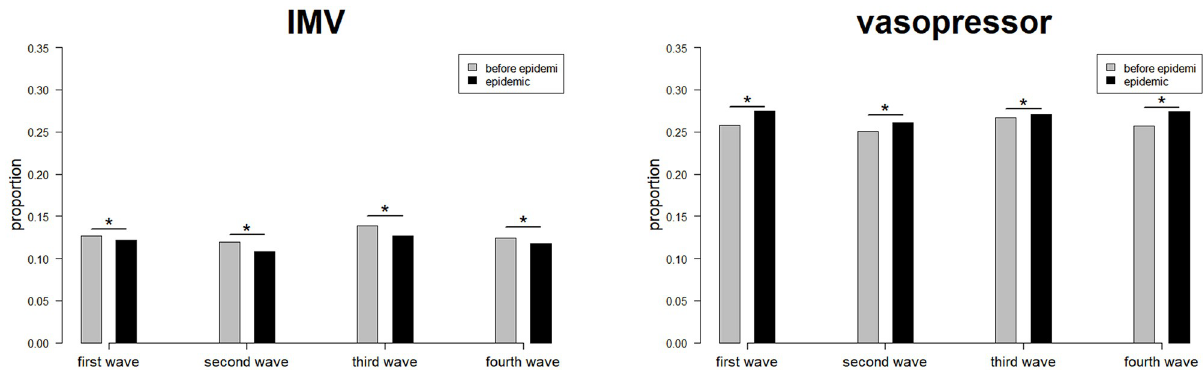
Fig 3. Changes in the proportion of initial treatments received by non-COVID-19 ICU patients (IMV and vasopressors). COVID-19, Coronavirus disease 2019; ICU, intensive care unit; IMV, invasive mechanical ventilation. � Indicates a statistically significant difference.